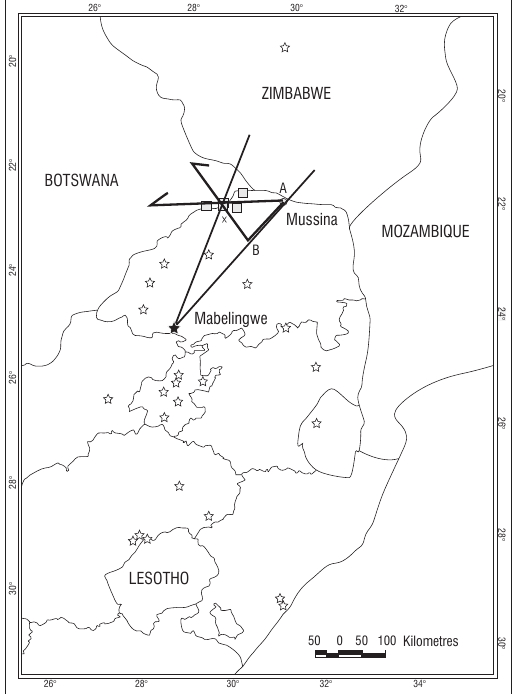
Figure 1: Map showing the locations at which the meteor was observed. Stars indicate locations at which the meteor was observed visually whereas squares indicate locations at which the meteor was seen as well as heard or felt. The two lines radiating from Mabelingwe show the limits over which the meteor was observed visually from this location. Point A shows the point where the meteor would have entered the atmosphere assuming it became visible at an altitude of 120 km and Point B shows the corresponding point for an altitude of 80 km. Two possible trajectories are indicated which pass through the locus of points with the highest number of audible or felt